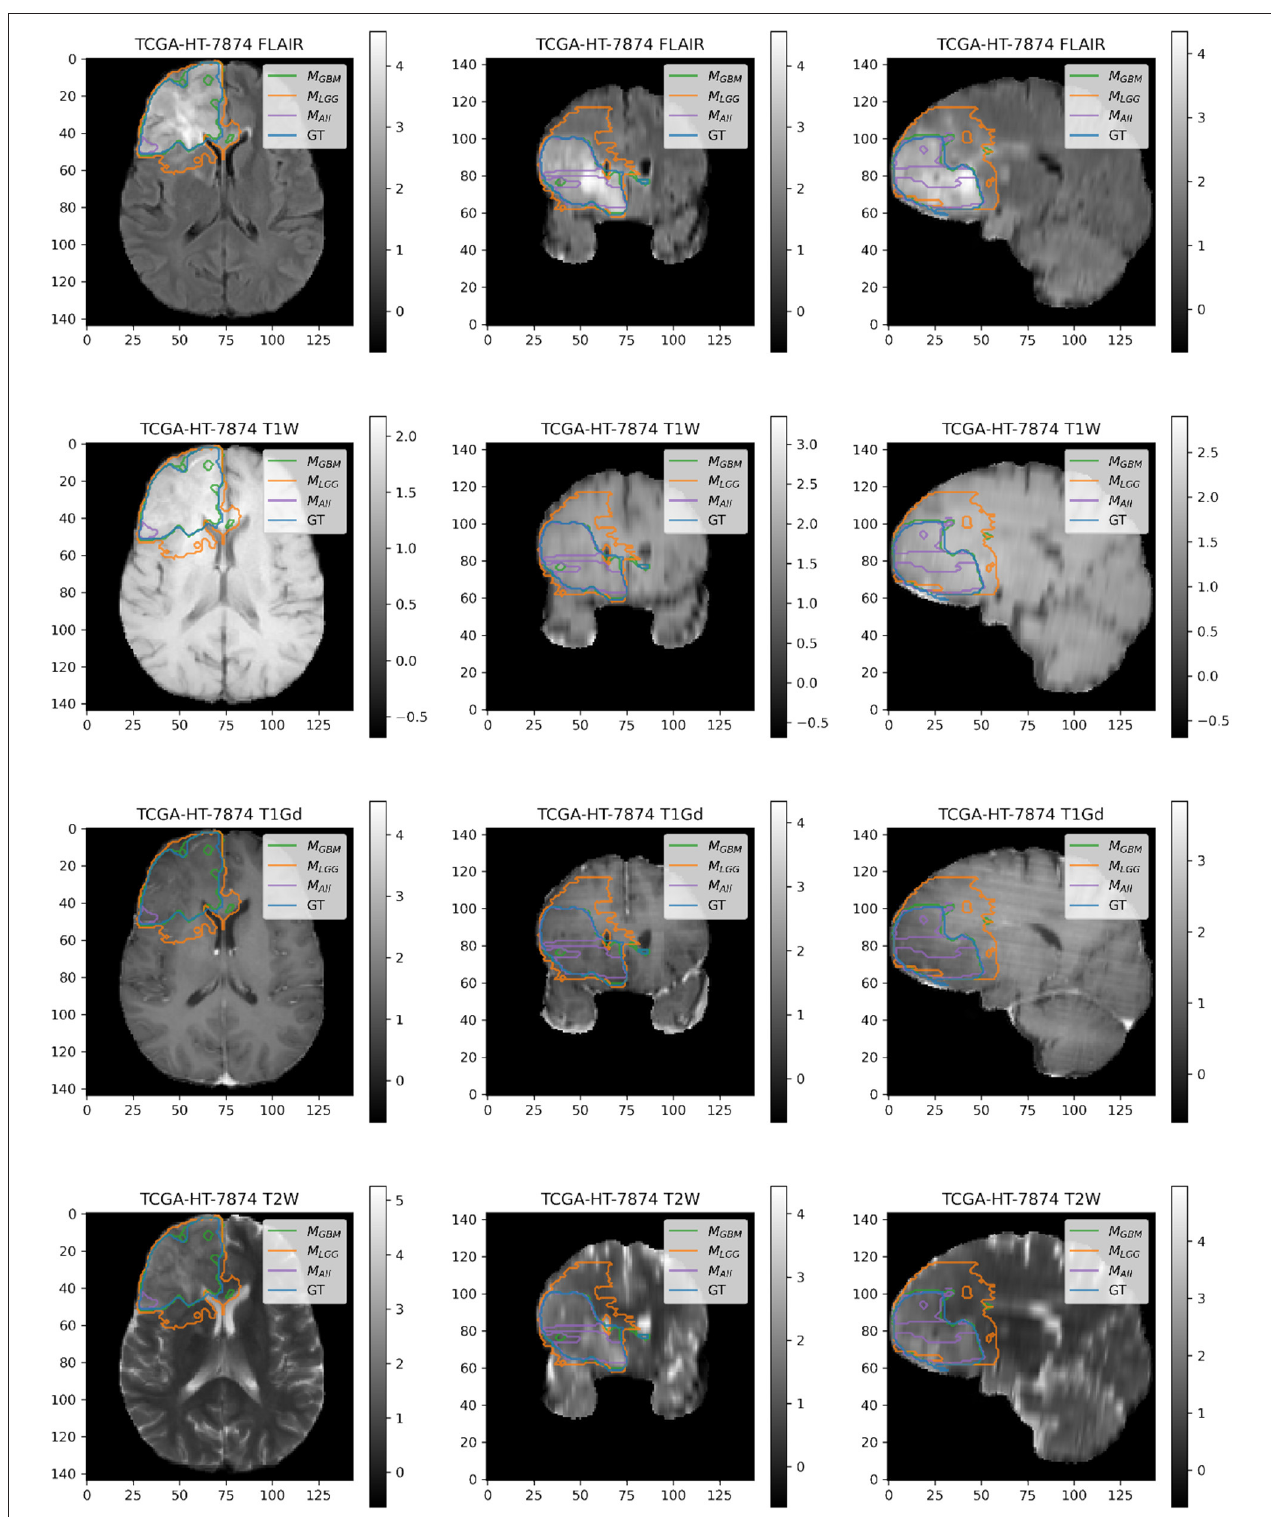
FIGURE 5 | Patient TCGA-HT-7874 belongs to D LGG and has a tumor in the right frontal lobe. We selected this patient as it has consistently worse performance for metrics (Sens, B.Acc, Dice, Jac.C) across all models. Segmentation plot indicates M All and M GBM under-segment in this case, whereas M LGG over-segments. M ALL appears to be missing a central part of the tumor, as seen in the coronal and sagittal image planes. M LGG appears to extend well beyond the region of FLAIR enhancement to over-segment the tumor. This LGG was significantly larger than most LGGs, and that may contribute to the difficulty of segmentation.